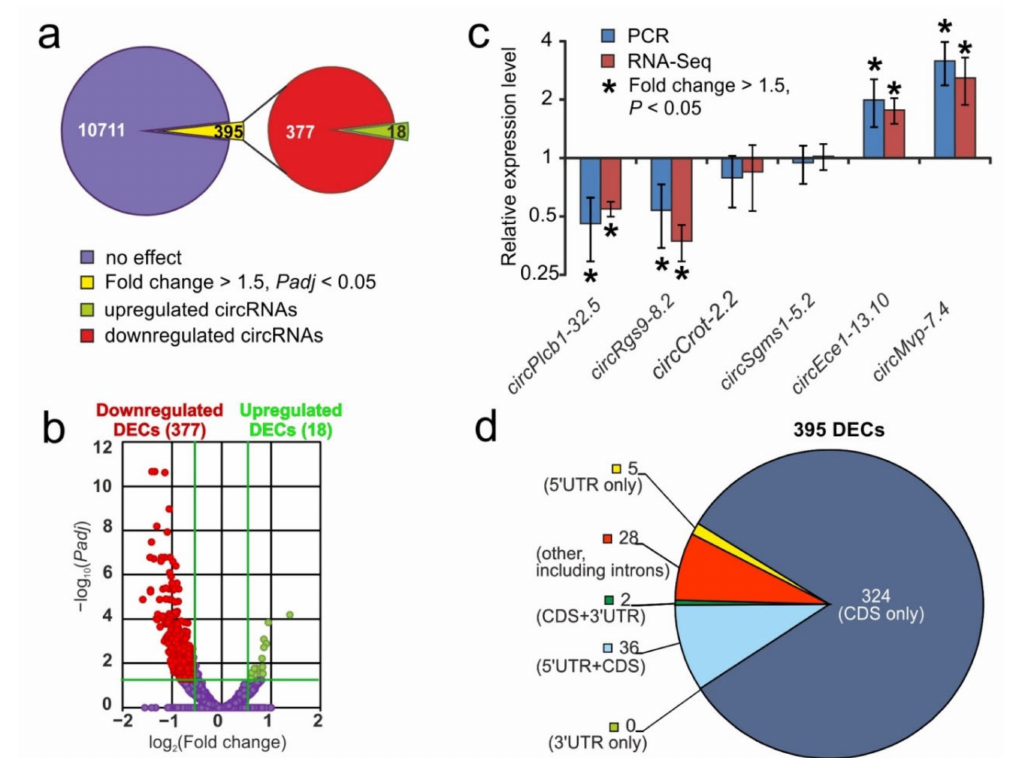
Figure 3. RNA-Seq analysis of DECs at 24 h after tMCAO. ( a ) RNA-Seq results in IR24 versus SH24. The numbers in the diagram sectors indicate the number of DECs. ( b ) A volcano plot shows the distributions of genes between the IS24 and IR24 groups. Up- and downregulated DECs are represented as red and green dots, respectively (fold change > 1.50. Padj < 0.05). Not differentially expressed circRNAs (non-DECs) are represented as dark purple dots (fold change ≤ 1.50. Padj ≥ 0.05). ( c ) RT-PCR verification of the RNA-Seq results. Data for comparison in IR24 versus SH24 are shown. Two reference mRNAs for Gapdh and Rpl3 were used to normalize the PCR results. In each group, there were at least 5 rats. Four circRNAs that change the expression more than 1.5-fold from the baseline value and whose p -value was lower 0.05, as well as two other circRNAs, were selected for analysis. ( d ) Annotations of genomic regions mapping to DECs. Numbers in sectors indicate the number of DECs contained corresponding to structural elements of